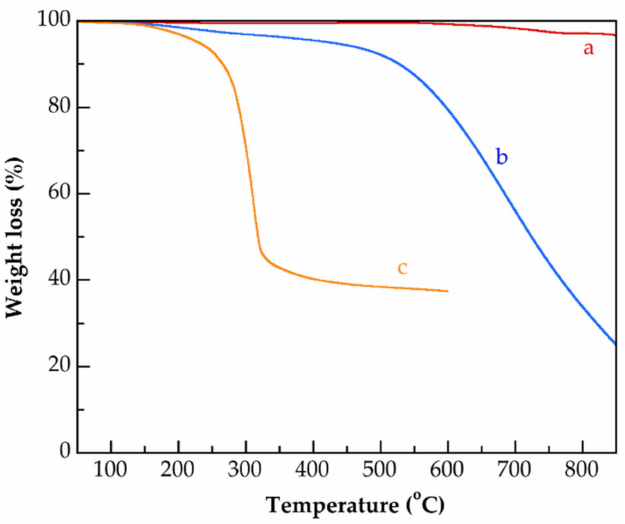
Figure 8. T g thermograms of CNTspur ( a ), CNTsoxid ( b ), and G3.0-CNTs-PAMAM-NH 2 ( c ).